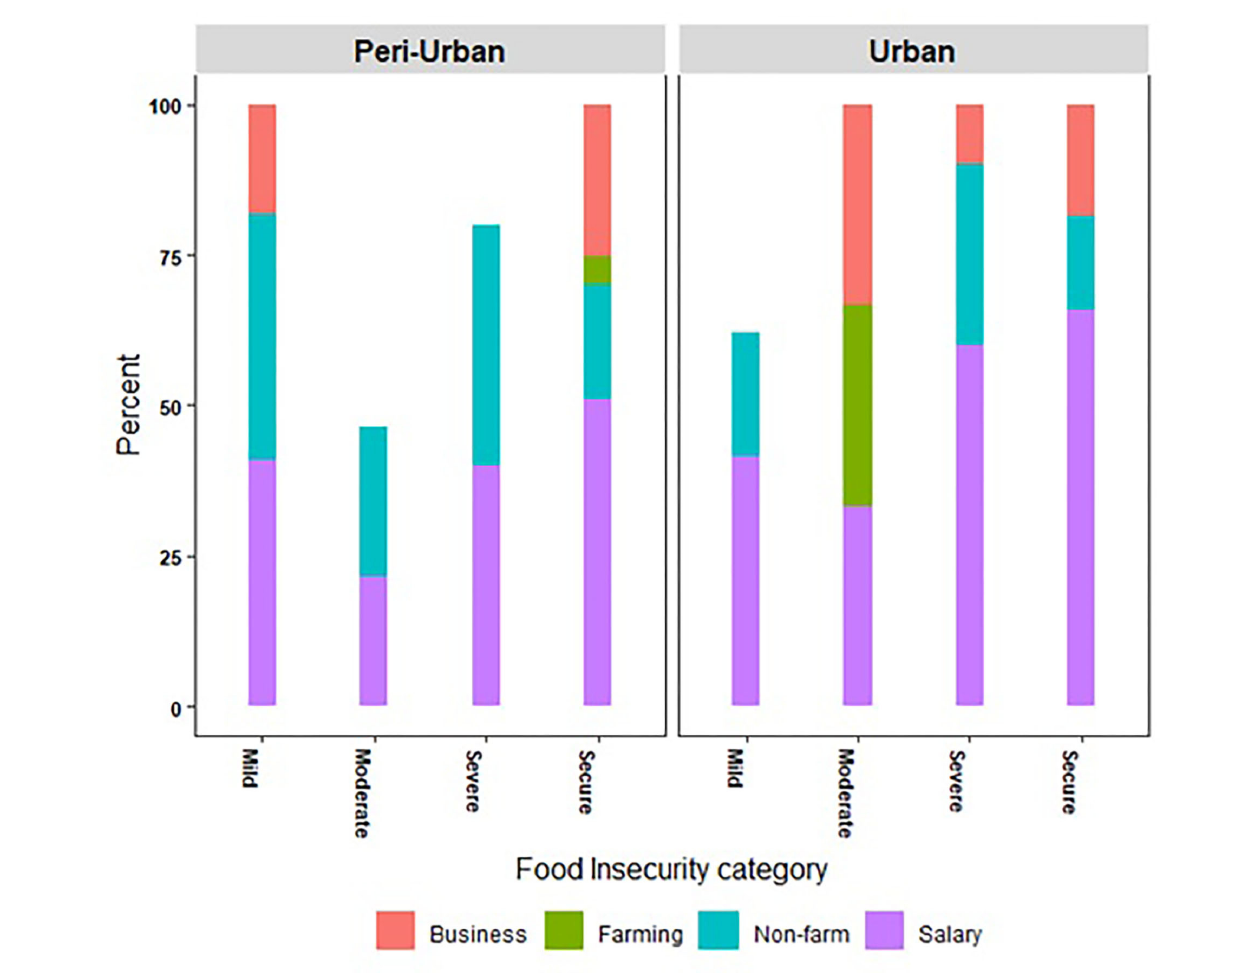
FIGURE 5 | Household food insecurity status by type of employment in urban and peri-urban areas of Hyderabad.